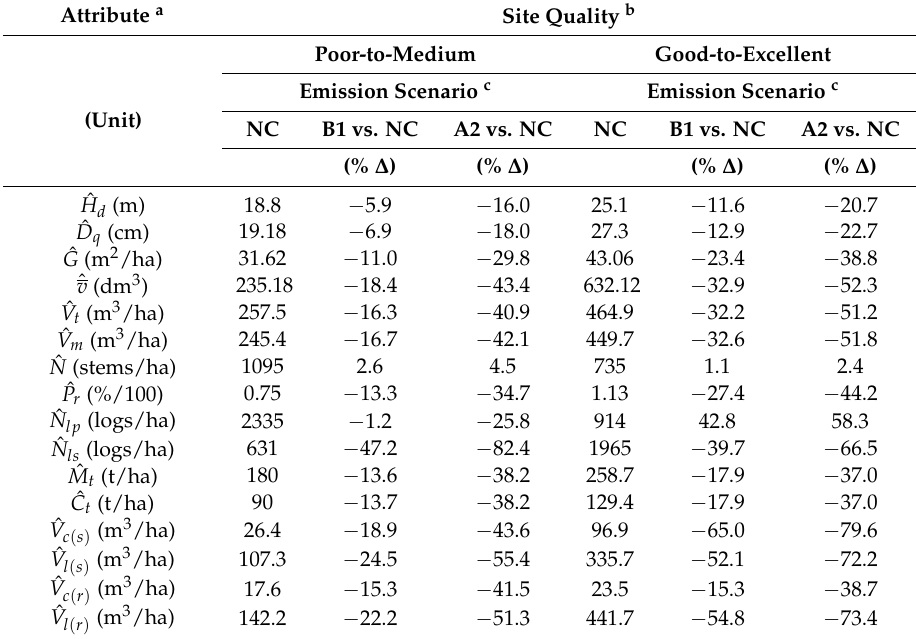
Table B1. Rotational yield estimates for jack pine plantations managed under a basic silvicultural intensity in north-eastern Ontario by emission scenario and site